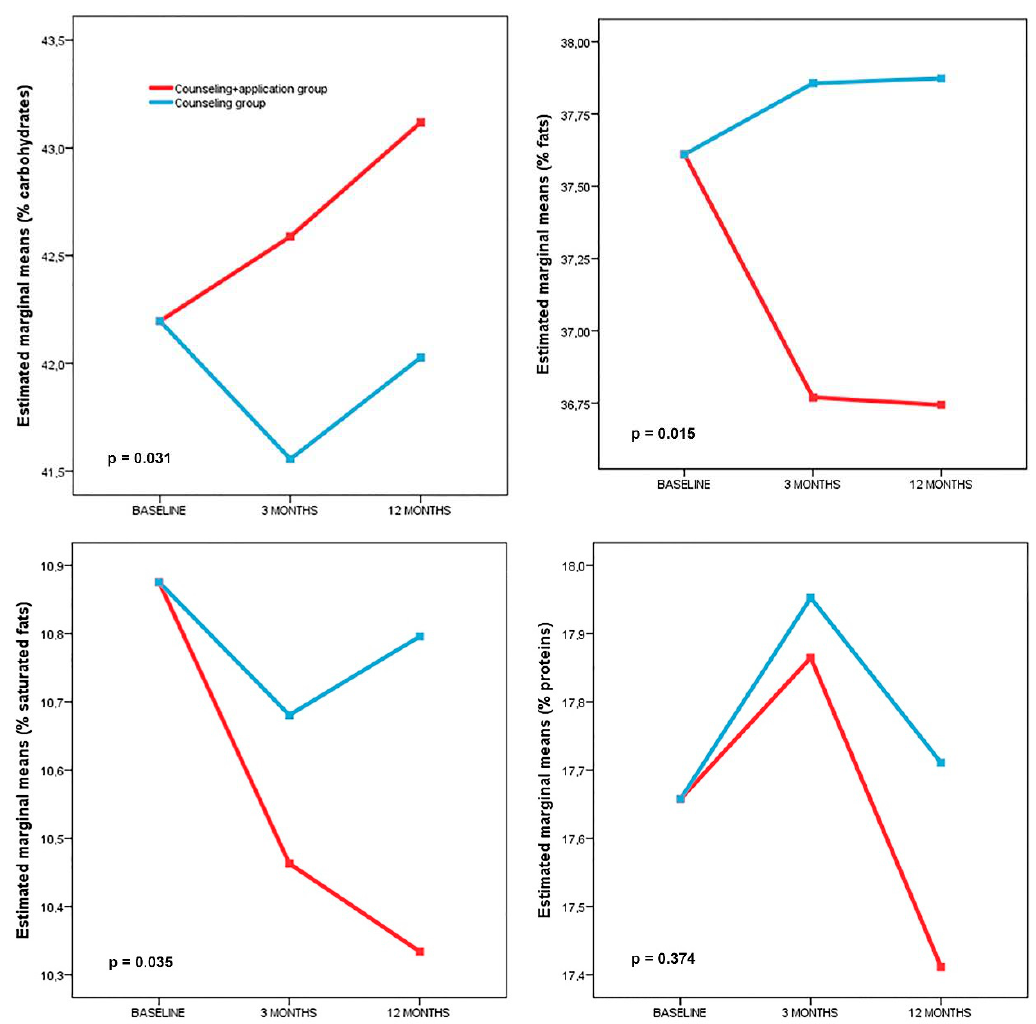
Figure 3. Changes in macronutrients after randomization by group (repeated measures Figure 3 . Changes in macronutrients after randomization by group (repeated measures analysis).